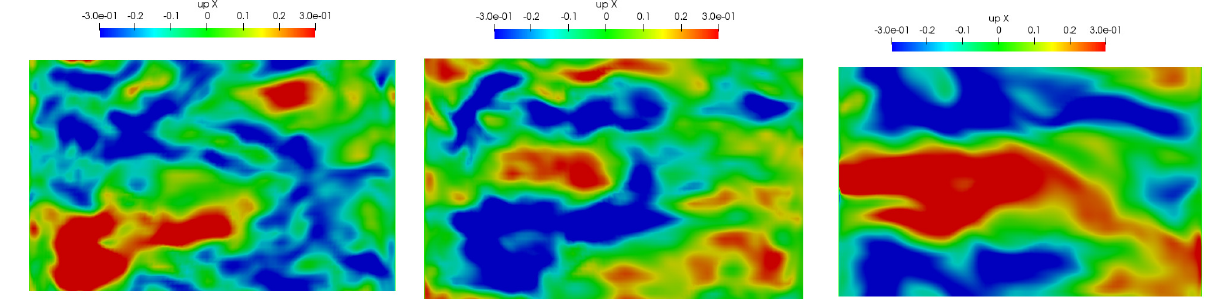
Figure 4. Streamwise velocity fluctuations u (xz-plane, y / h = 0.5) using the CES-KOKU model on the 500 K grid: Re = 37 K ( left ), 100 K ( middle ), 500 K ( right